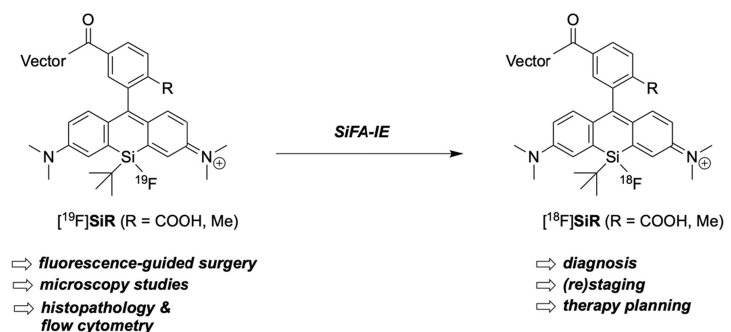
Figure 2. The non-radioactive bimodal imaging tracer [ 19 F] SiR can be clinically applied for fluores- cence-guided surgery or as a probe for (preclinical) microscopy studies. The PET-activated and ra- dioactive compound [ 18 F] SiR can be clinically utilized for diagnosis, (re)staging, and therapy plan- ning (surgical intervention, radiotherapy, and targeted radioligand therapy). Furthermore, it allows us to correlate tumor uptake in PET with immunohistochemistry or FACS (fluorescence-activated cell sorting)